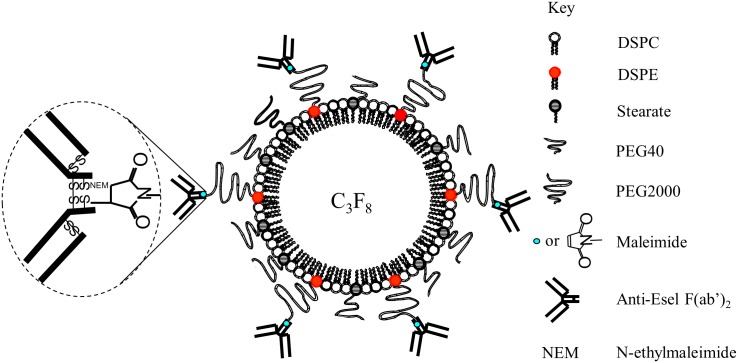
Schema of Esel targeting microbubble.